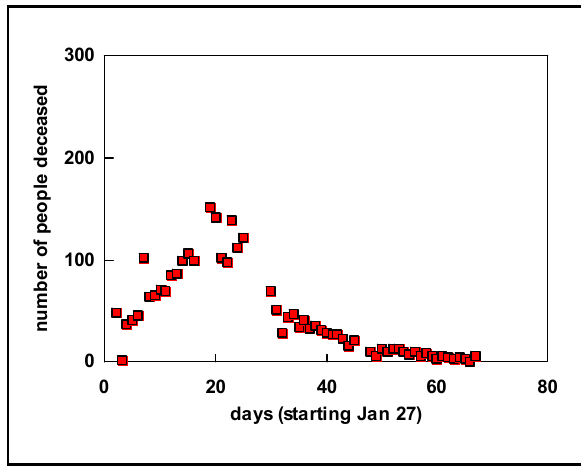
Figure 7. Daily increments of deaths in China during the main period of the corona crisis.